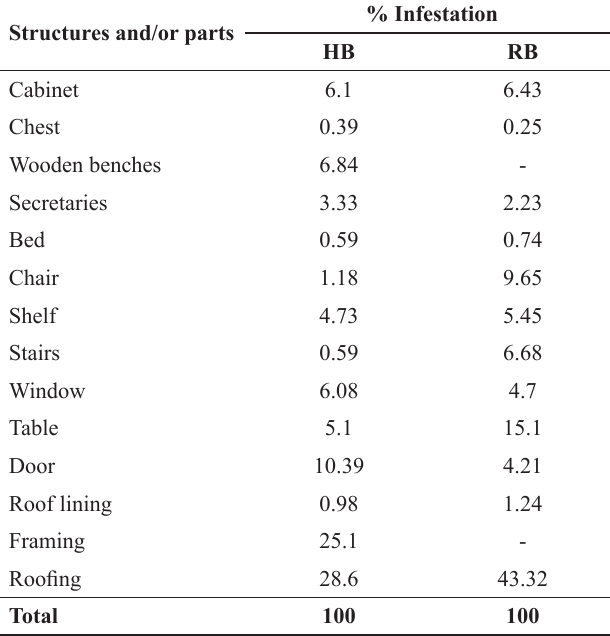
Table 2 – Wooden parts and/or structures with termite’s infestations in historical (HB) and residential (RB) buildings in the municipalities of de Fagundes (A1), Pocinhos (A2), Alagoa Grande (A3), Areia (A4) and Bananeiras (A5), located in the semiarid region of Brazil. (HB – historical buildings; RB – residential